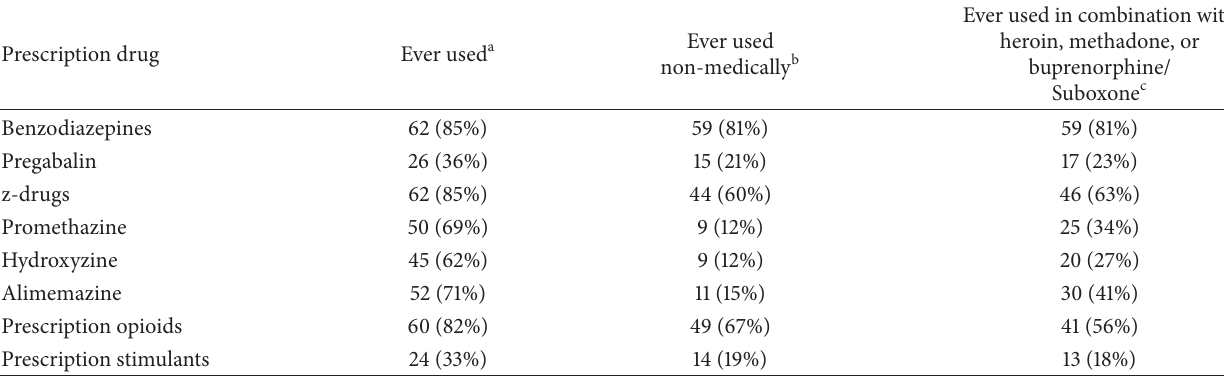
Table 2: Use and non-medical use of prescription drugs ( 𝑁 = 73